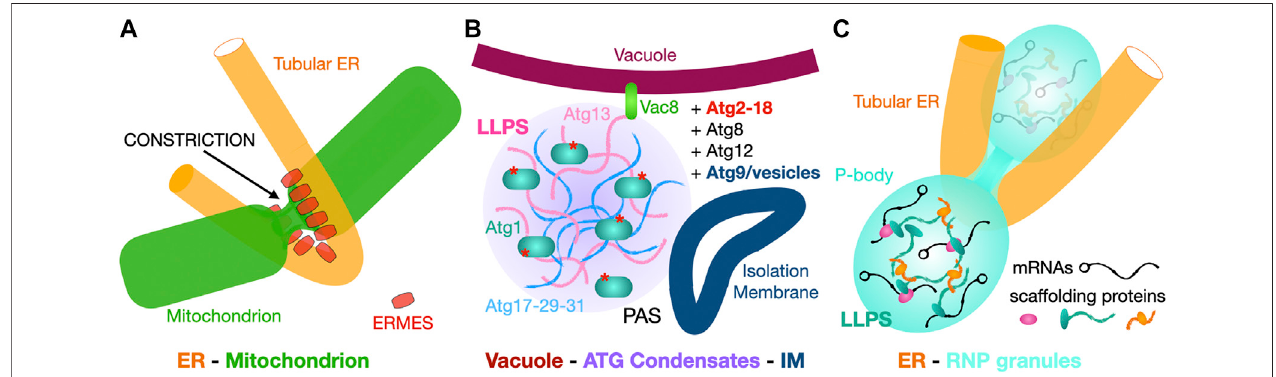
FIGURE 14 | Membrane and membrane-less contact sites. (A) “ Classic ” membrane to membrane contact site. The ER tubular network contacts mitochondria at constrictions marking their division. In yeast tethers such as ERMES are involved at these sites. (B, C) . Membrane to membrane-less contact sites. (B) Vacuole-to-Atg complexcondensate interactionsdriveisolation membraneformation at theER-Vacuole-PAS contact site. Scramblase Atg9-vesicles derivedfrom theGolgi provide the initial IM (phagophore) that will later expand into the autophagosome using ER lipids supplied by Atg2. (C) The ER tubular network contacts membrane-less P-bodies and regulates their biogenesis and activity. Simpli fi ed schematic of the content of PBs with RNPs made of repressed mRNA associated with multivalent scaffolding proteins that drive LLPS and formation of this membrane-less compartment.